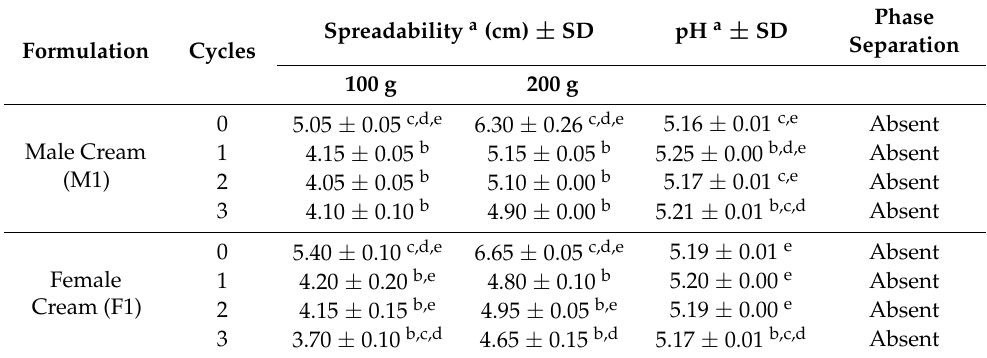
Table 5. Spreadability, pH and physical stability of creams throughout freeze–thaw cycles.